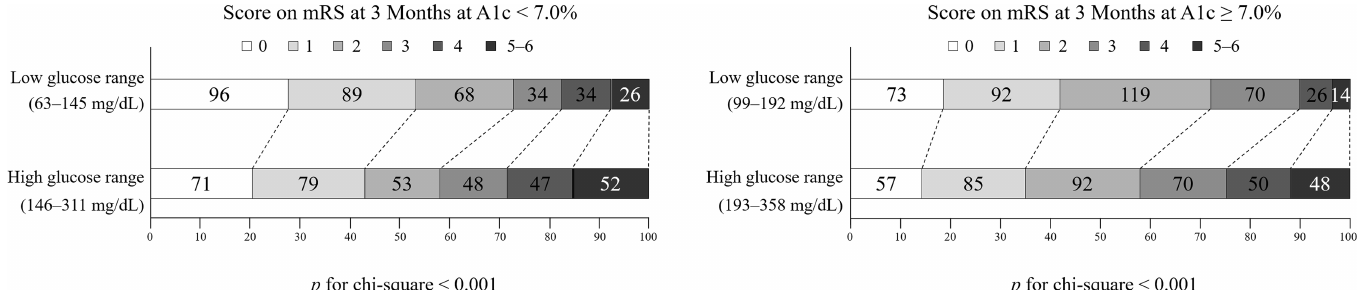
Fig 2. Distribution of the modified Rankin Scale (mRS) scores at 3 months after stroke onset according to the glucose range and glycated hemoglobin (A1c)